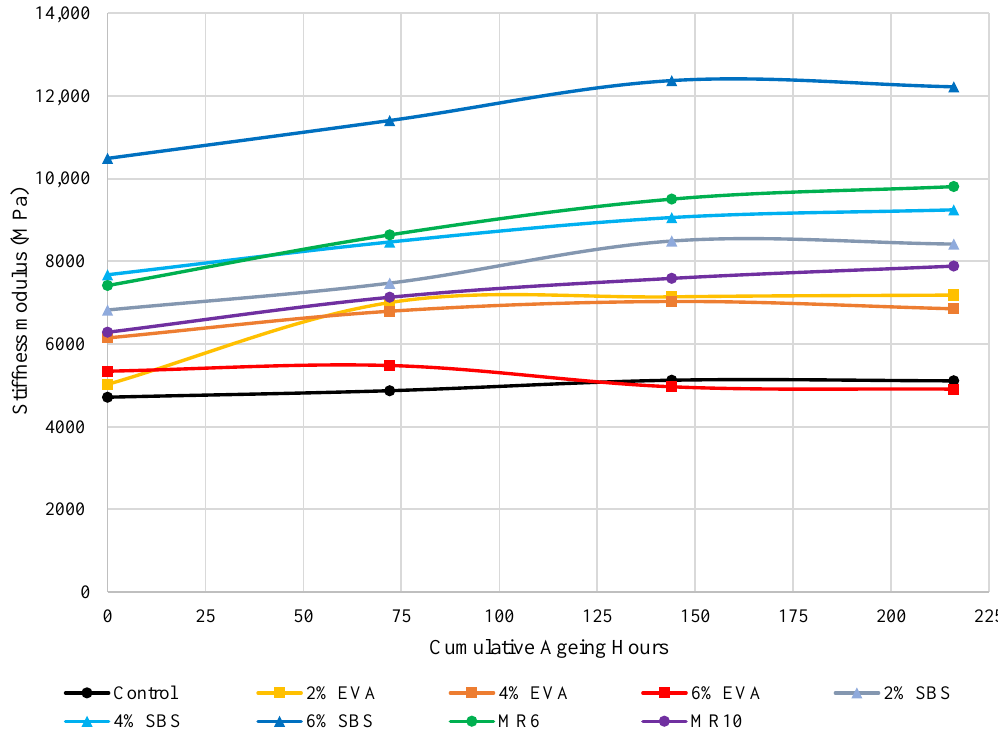
Figure 3. Asphalt mixture stiffness modulus before and after ageing cycles.